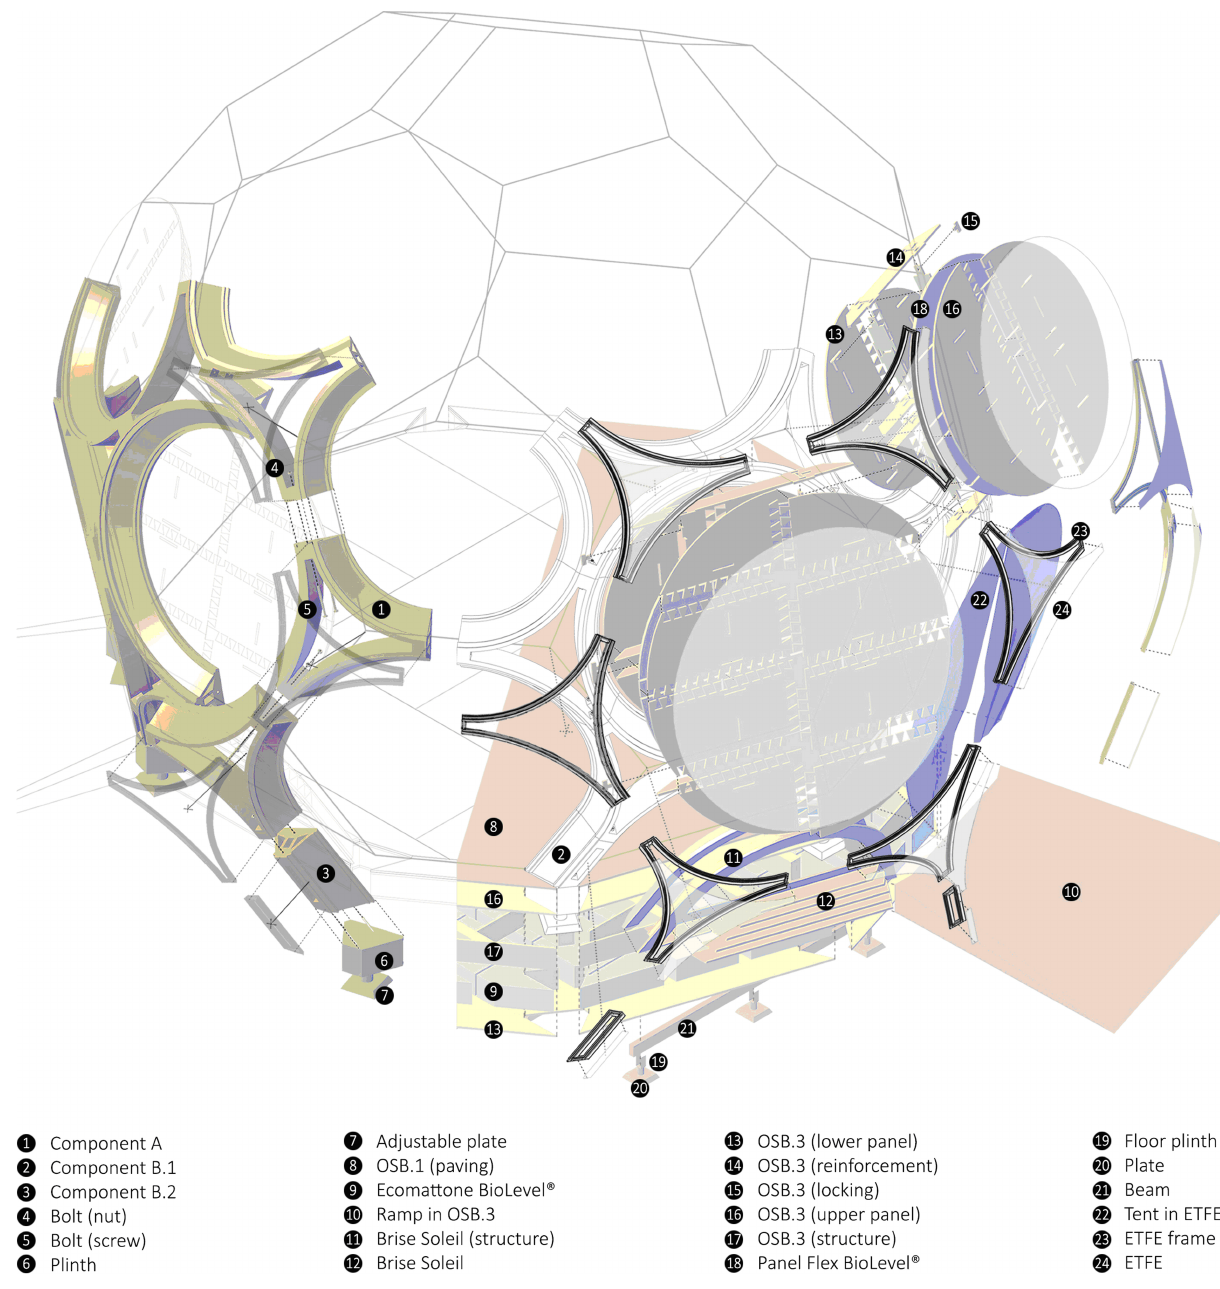
Figure 11: Axonometric exploded view of the exhibit pavilion